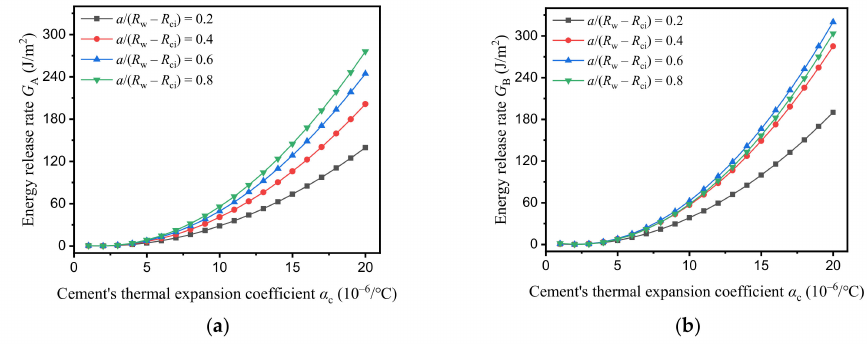
Figure 9. E ff ect of cement’s Poisson’s ratio on radial cracking: ( a ) crack tip A and ( b ) the crack tip